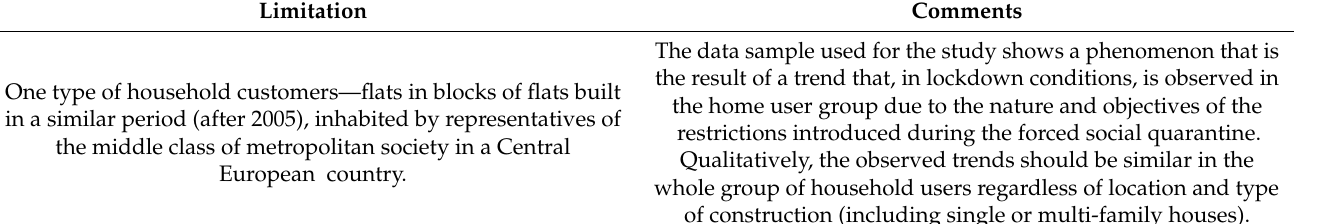
Table 2. Main limitations of the